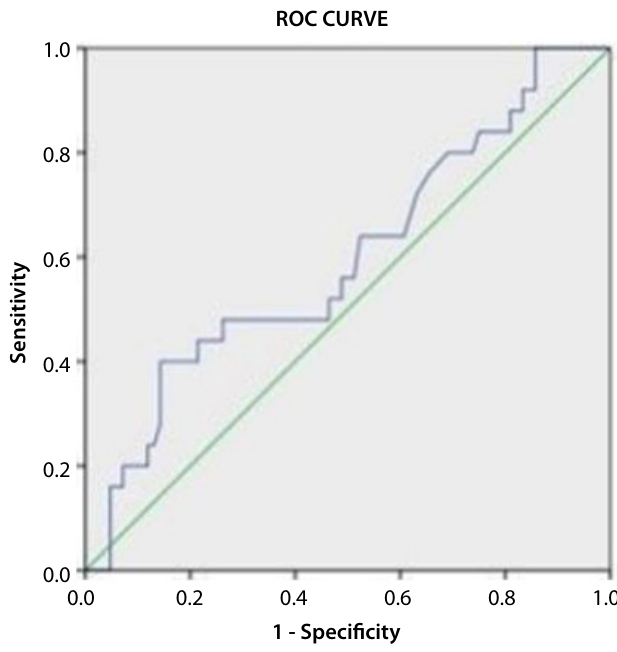
1 - Specificity Diagonal segments are produced by Fig. 1 – Receiver operating characteristic (ROC) curve for vitamin D for predicting high SYNTAX (synergy between percutaneous coronary intervention with taxus and cardiac surgery) score